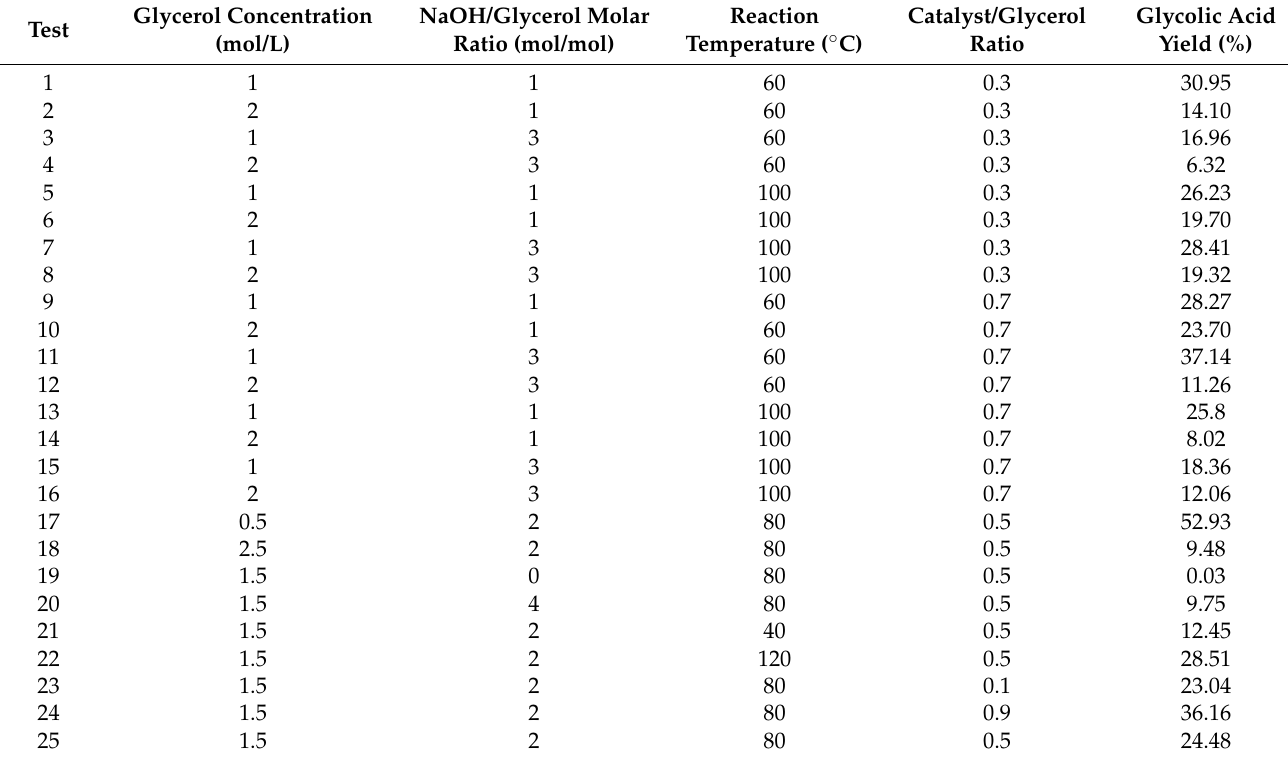
Table 4. Experimental results obtained at each operating conditions of the CCD 1.